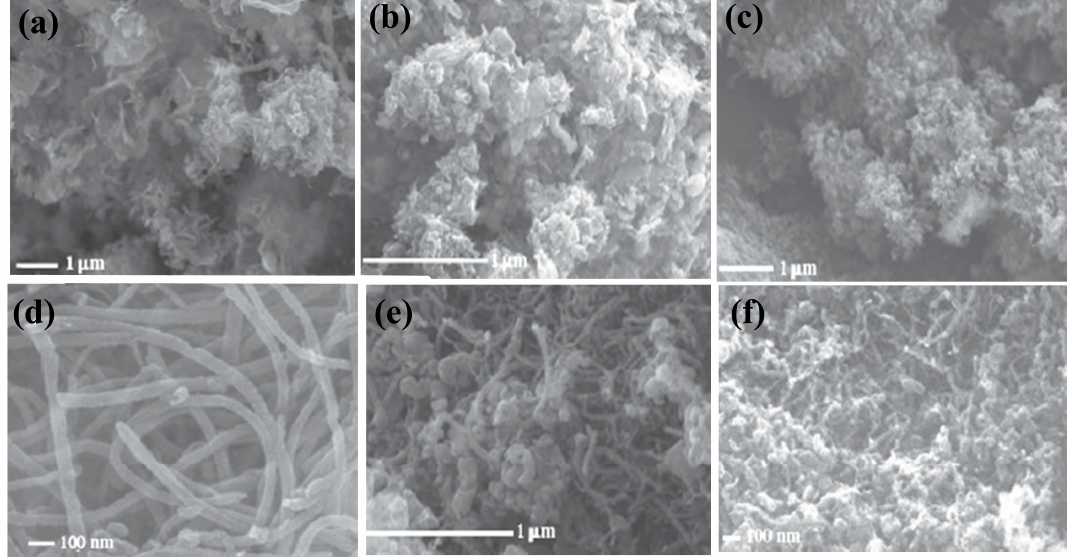
Figure 3. The initial product synthesized by using ( a ) iron(III) nitrate; ( b ) iron(III) chloride; and ( c